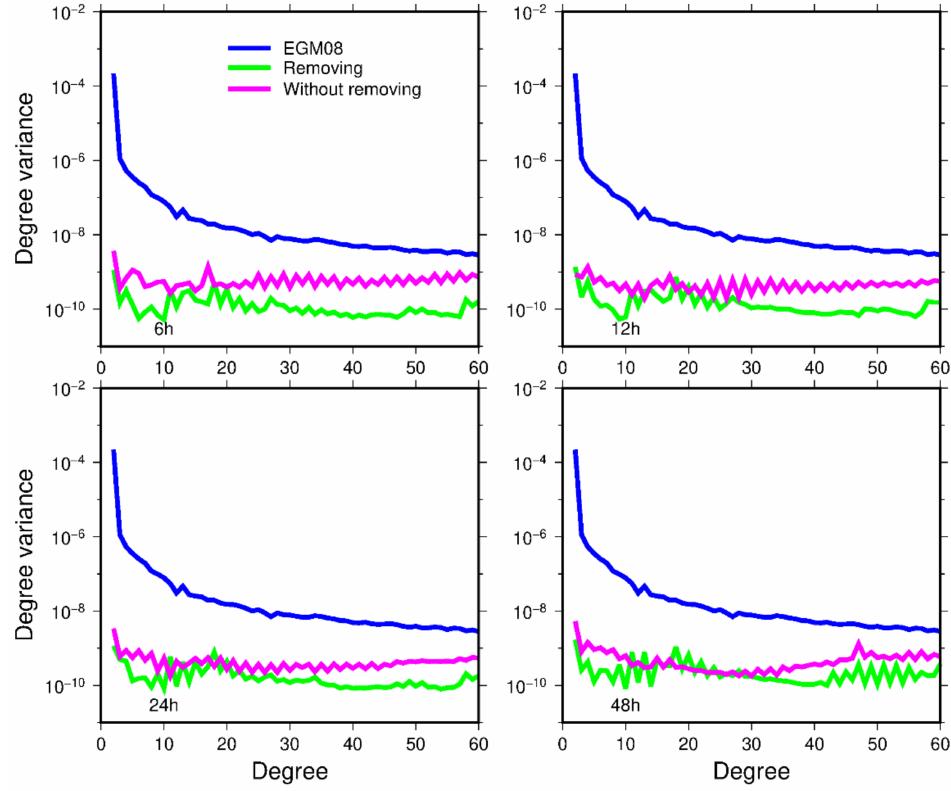
Figure 3. The degree variance of the recovery gravity field by using 6, 12, 24 and 48 h arcs, when using the range rate data to recover the gravity field.